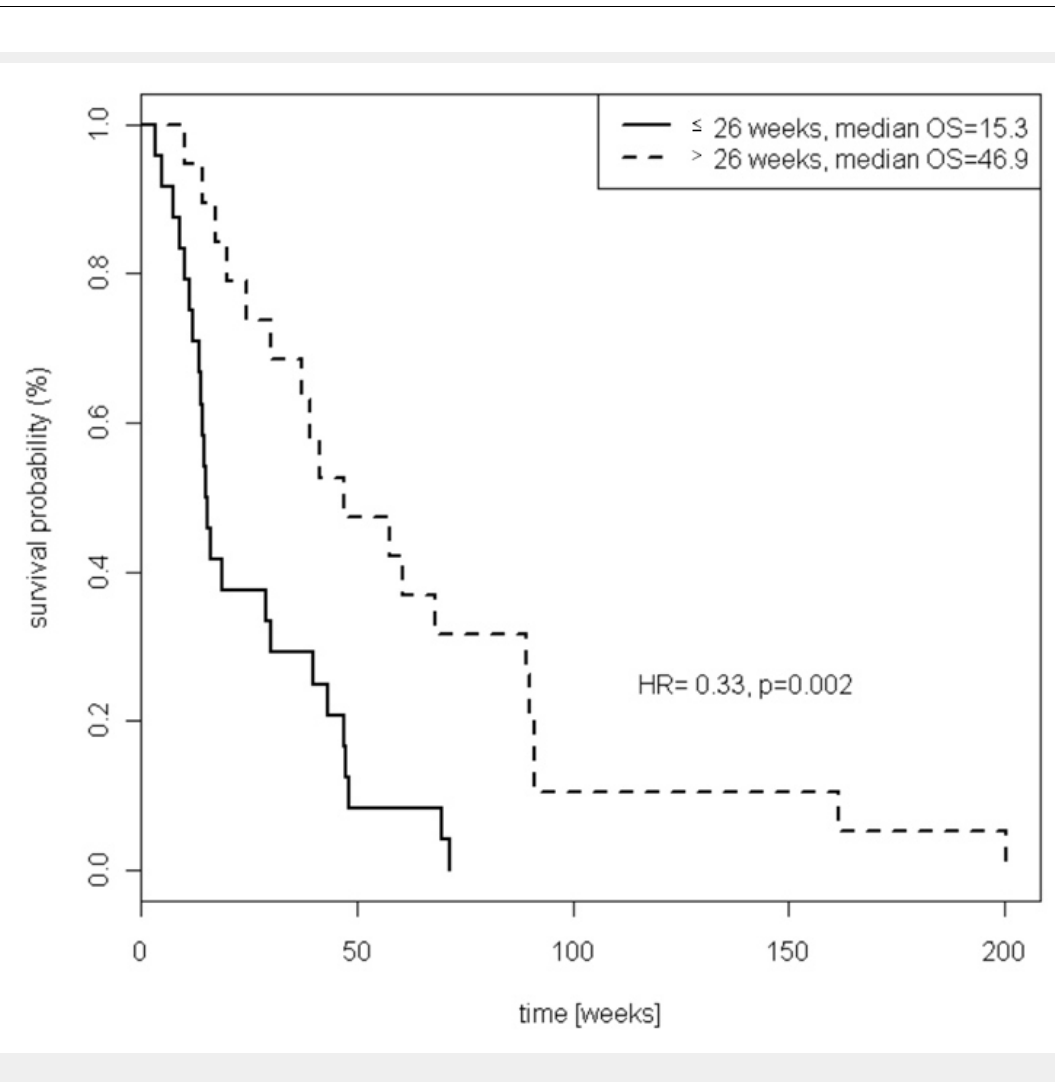
Figure 1 Kaplan-Meier estimates of overall survival by progression free survival at 1 st line chemotherapy, less than or equal to 26 weeks versus greater than 26